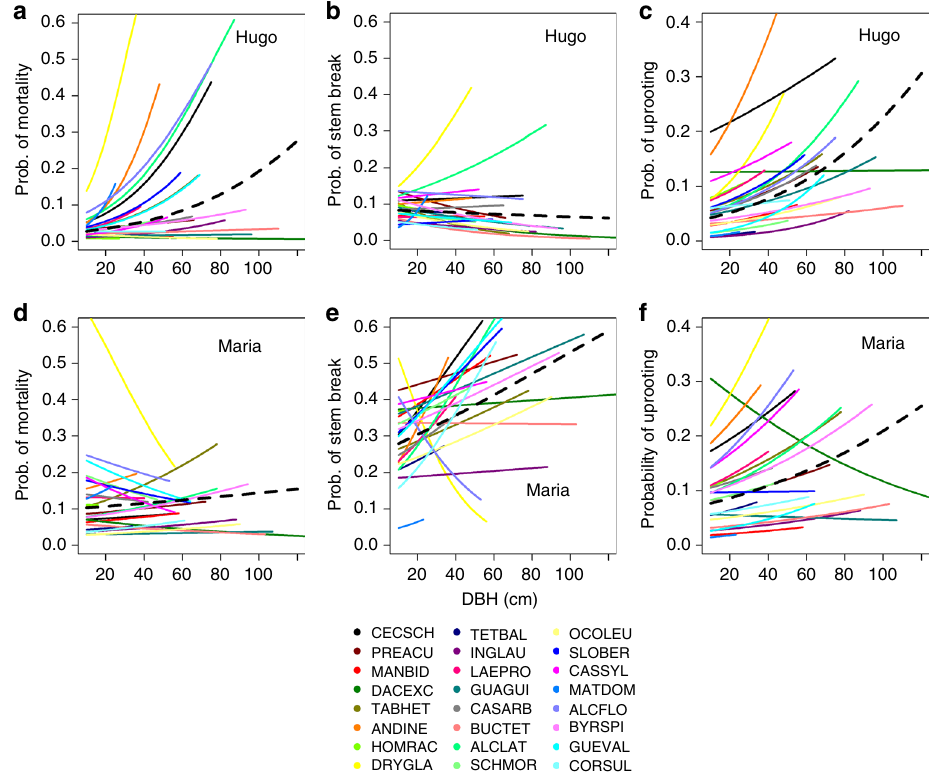
Fig. 3 Relationship between species diameter and rates of stem break ( a , d ), uprooting ( b , e ), and mortality ( c , f ) in H. Hugo and María. Black dashed lines depict community-wide rates. Individual species estimates are restricted to the maximum observed dbh in the